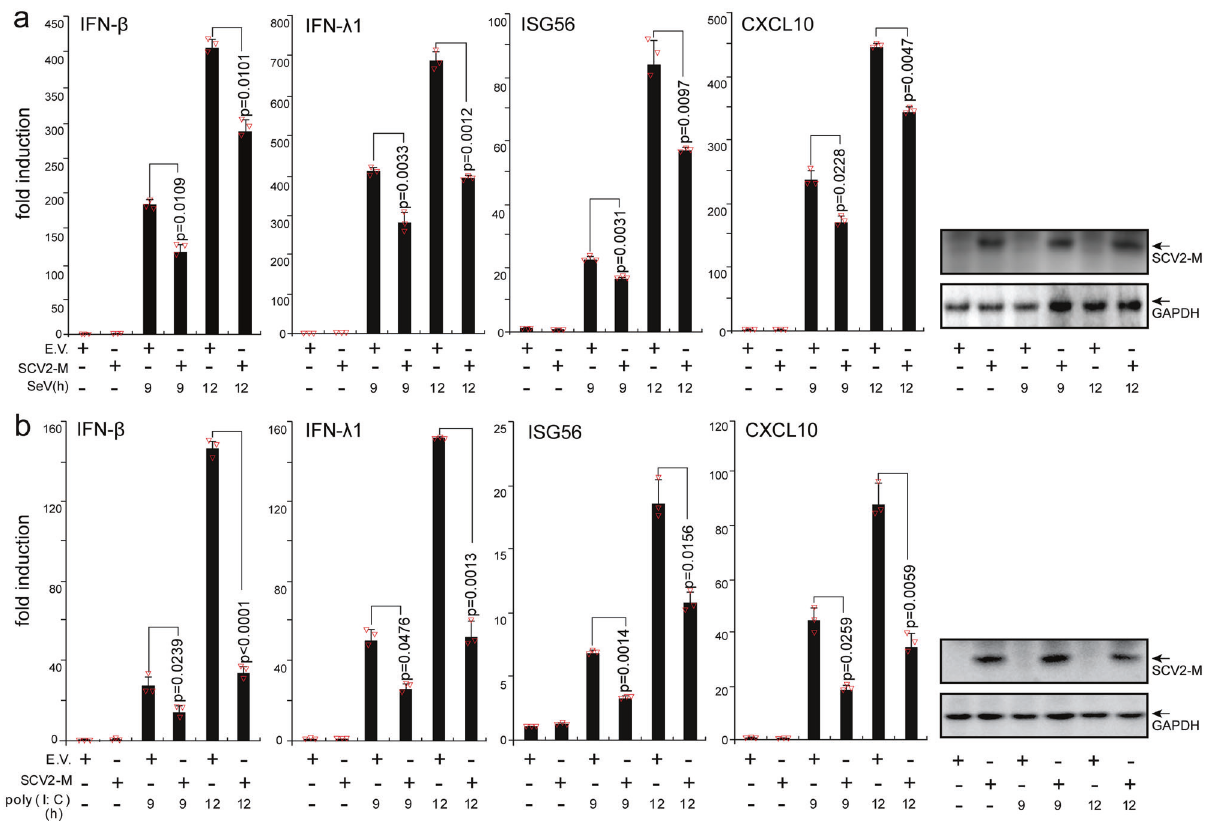
Fig. 1 The SARS-CoV-2 M protein inhibits the induction of IFN- β , IFN- λ 1, ISG56, and CXCL10 by SeV infection and poly (I:C) transfection. HEK293T cells cultured in 24-well plates (0.8 – 1 × 10 5 cells per well) were transfected with pcDNA6B empty vector (E.V., 500 ng) or the SCV2-M plasmid (500 ng). Twenty-four hours after transfection, cells were stimulated by SeV infection ( a ) or poly (I:C) transfection ( b ) as indicated, and at 9 and 12 h after stimulation, the cells were harvested for RNA extraction and subsequent RT-qPCR analysis. Three independent biological replicates were analyzed, the results of one representative experiment are shown, and the error bars indicate the SD values. Statistical signi fi cance is shown as indicated. SARS-CoV-2 M protein SCV2-M; hours